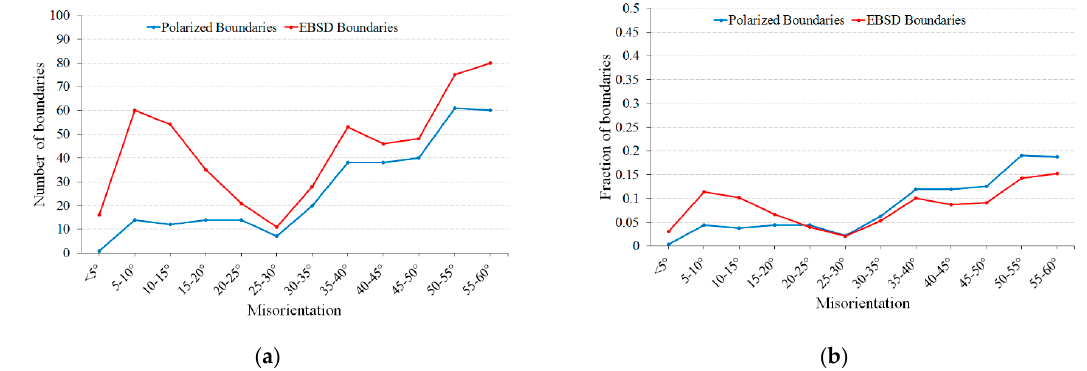
Figure 9. Number of identified boundaries ( a ) and fraction of boundaries ( b ) based on the misorientation angles, as-cast EMS billets, sand mold billets.